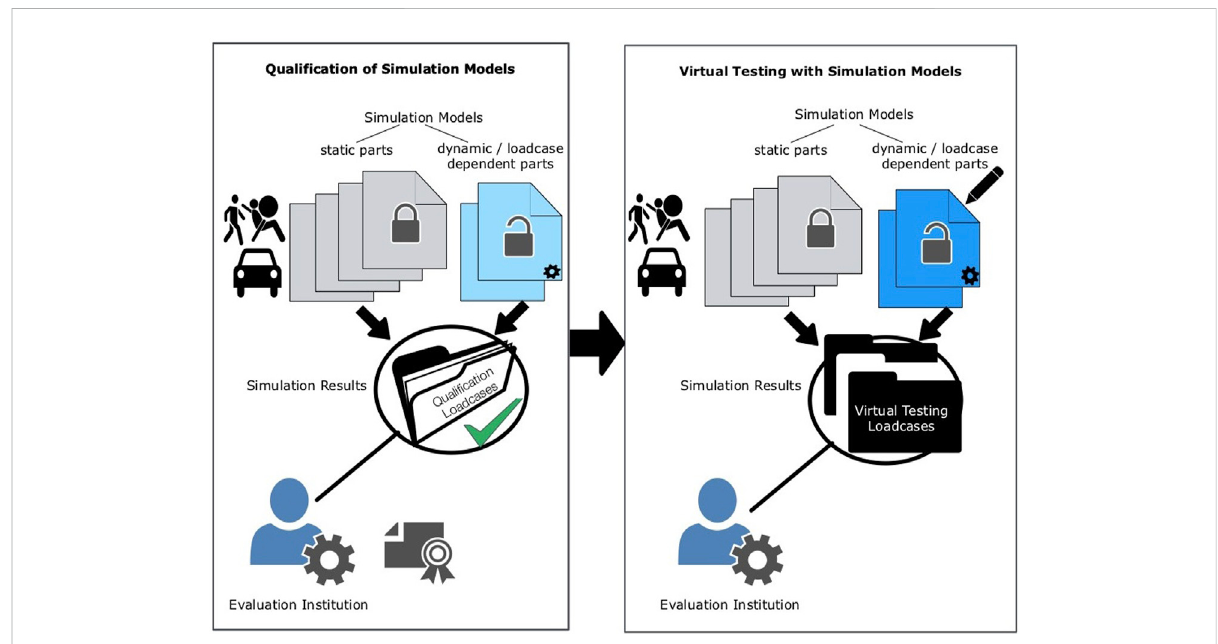
FIGURE 1 Possible implementation of virtual testing procedure where evaluation institution has access to simulation results.